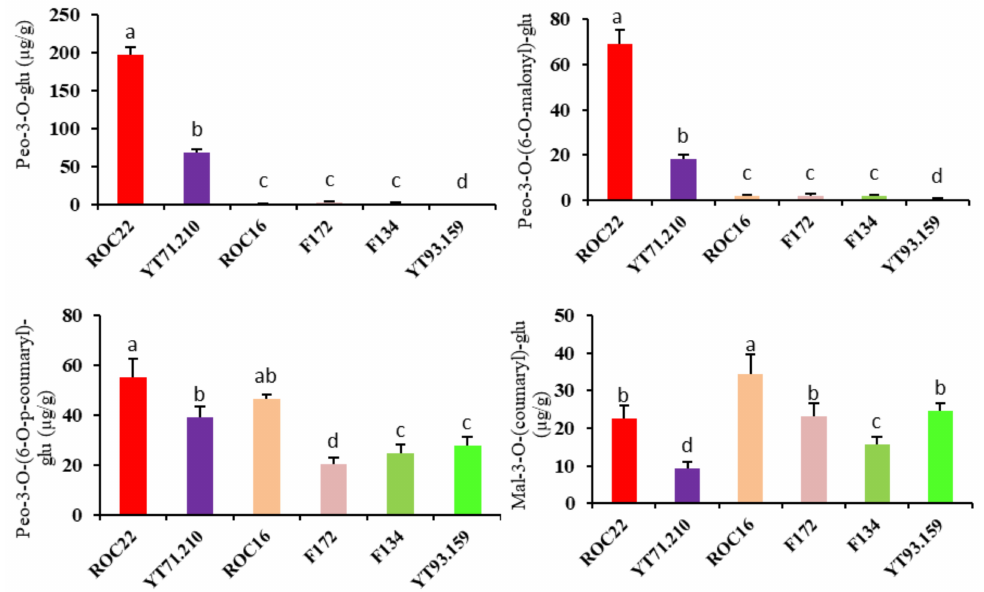
Figure 3. Relative abundance of major anthocyanins ( µ g/g) found in the rind of six cultivated sugarcane cultivars. Each graph represents the relative abundance of individual anthocyanidins in the rind of six sugarcane cultivars (denoted by six different colors). Each bar denotes the mean of three biological replicates. The least significant difference test was used at p <0.05 (a, b,